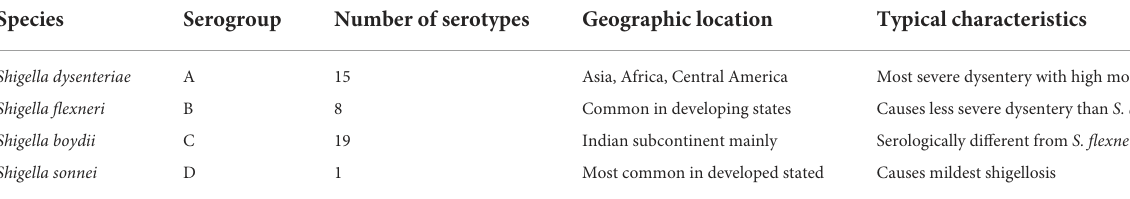
TABLE 2 Shigella serogroups and their characteristics.